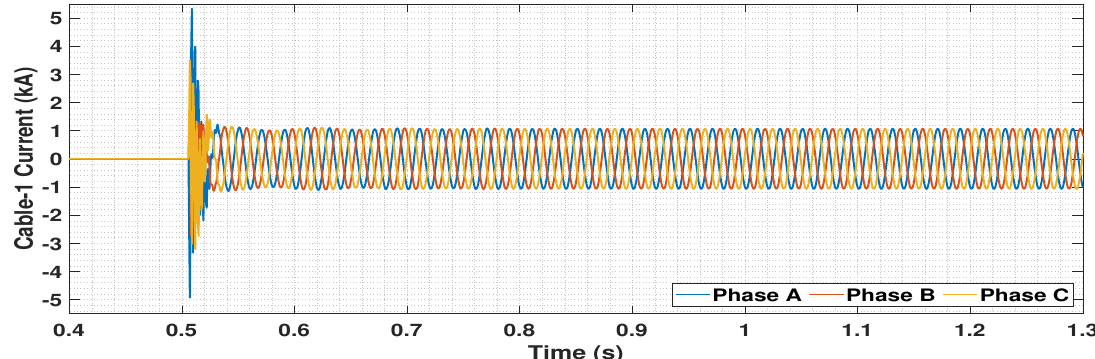
Figure 19. Currents in cable-1 upon CB-1a closing operation for charging of cable-1. After cable-1 has been charged, the breaker at the OWF-1 end (CB-1b) is switched on. OWF-1 gets connected to the network. As mentioned in Section 5.3, the OWF-1 is connected initially with less generation to keep the voltage at PCC-1 within limits. The initial high voltage at the PCC-1 before closing the breaker, as seen in Figure 20, is due to the capacitance at the DC link. Once the breaker is closed, the voltage is maintained at nearly 1 p.u. as shown in Figure 20. The currents through PCC-1 also increase as shown in Figure 21. The OWF starts generating ∼ 50 MW, which flows through MMC-1 as shown in Figure 22. In a similar way all other OWFs are connected. All OWFs are connected with ∼ 50 MW generation. A total power of ∼ 200 MW through MMC-1 after connection of OWF-1, OWF-2, OWF-3 and OWF-4 is clearly depicted in Figure 22. There is no flow of active power in MMC-2 (Figure 23) since the rated capacity of 1 GW of MMC-1 is yet to be reached.